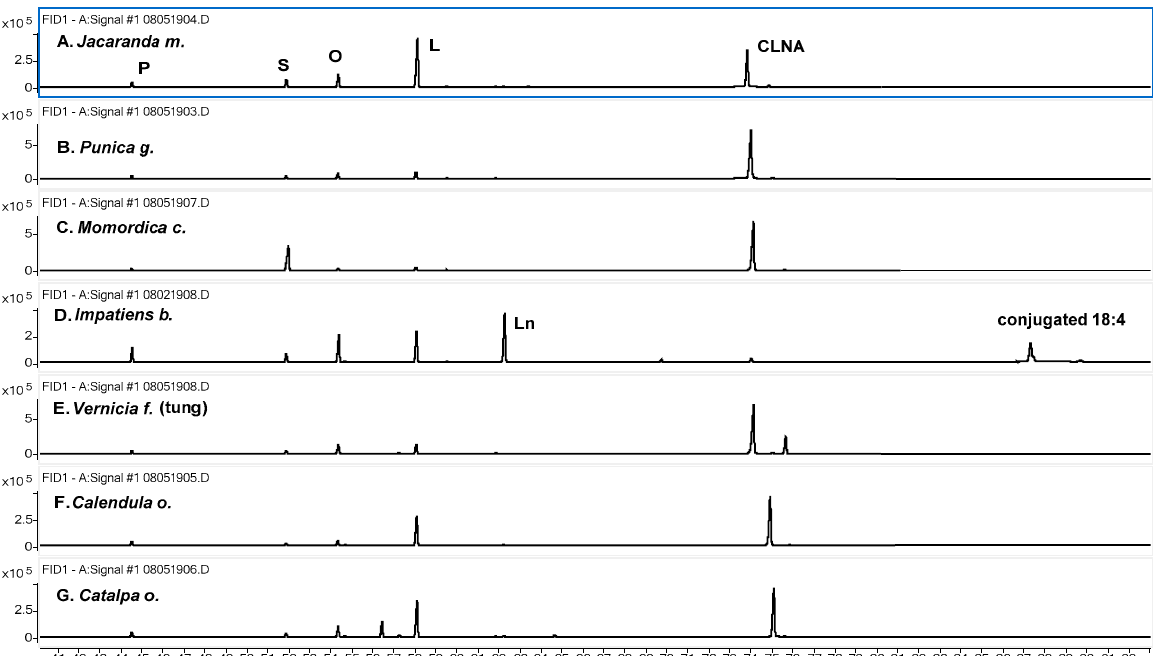
Figure 1. FID (flame ionization detector) chromatograms obtained using SP-2560 column of FAME (fatty acid methyl esters) of seven samples containing CLNA (conjugated linolenic acids).